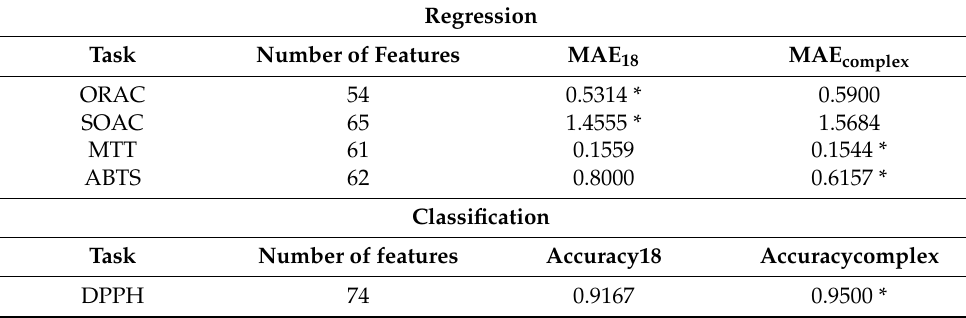
Figure 3. Confusion matrices for DPPH classification. ( a ) The classification performance of test data. ( b ) Plot indicating how well the classification model was trained. A score of 0 means no antioxidant capacity according to the DPPH assay, whereas 1 means that compounds in the area were effective. Table 5. Comparison of XGBoost models based on predictive performance for test data. The column “Number of features” shows the number of input features of comparative XGBoost models. MAE 18 means the MAE of a model trained with 18 common features, whereas MAE complex is the MAE of a model trained with a larger number of features. Accuracy was used in the DPPH task instead of MAE. * better performance